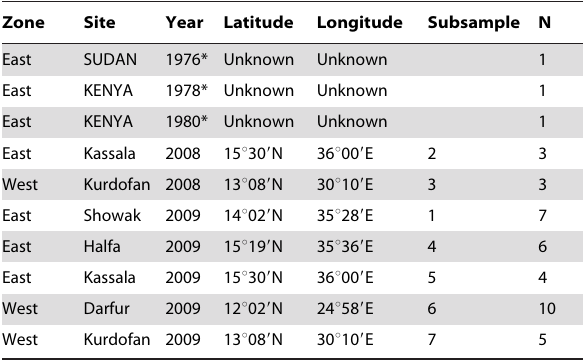
Table 1. Subsamples, zone (East or West Nile), site and year of sampling, GPS coordinates and number of genotyped isolates (N) of T. evansi.